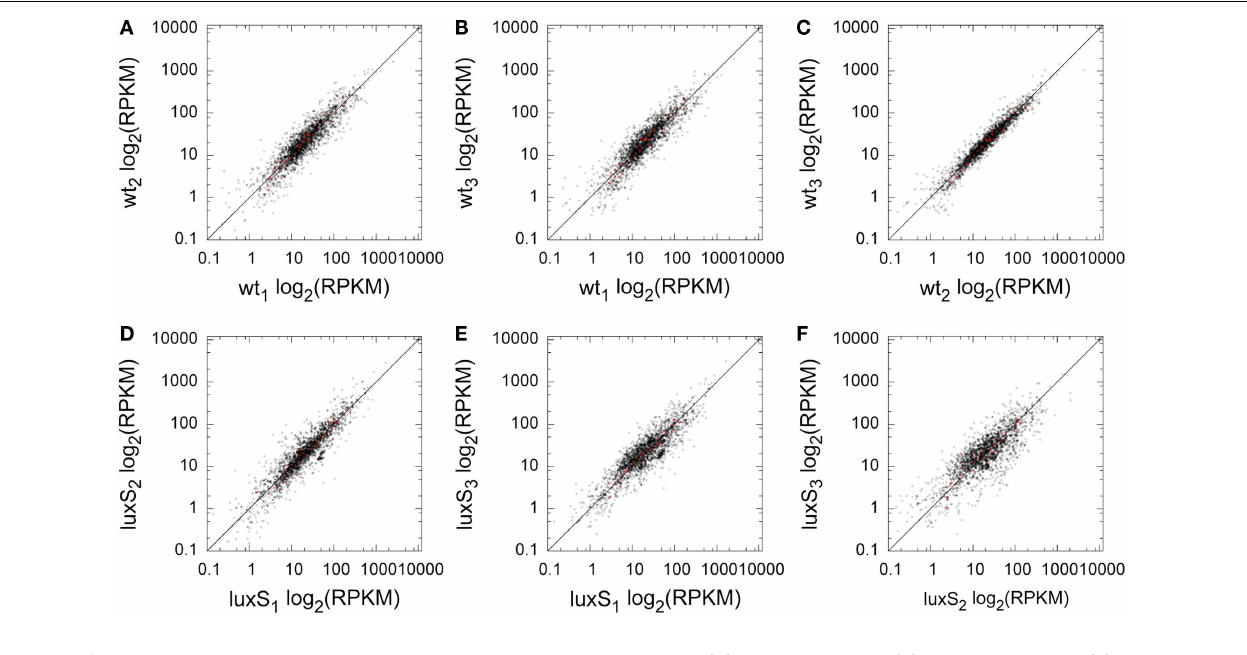
FIGURE 1 | Replicate comparison of per-locus RPKM for coding sequences. For a pair of replicates, each locus has one point with the log 2 RPKM in one replicate plotted against the log 2 RPKM of a second.The diagonal line shows identity. (A) WT1 vs.WT2, (B) WT1 vs.WT3, (C) WT2